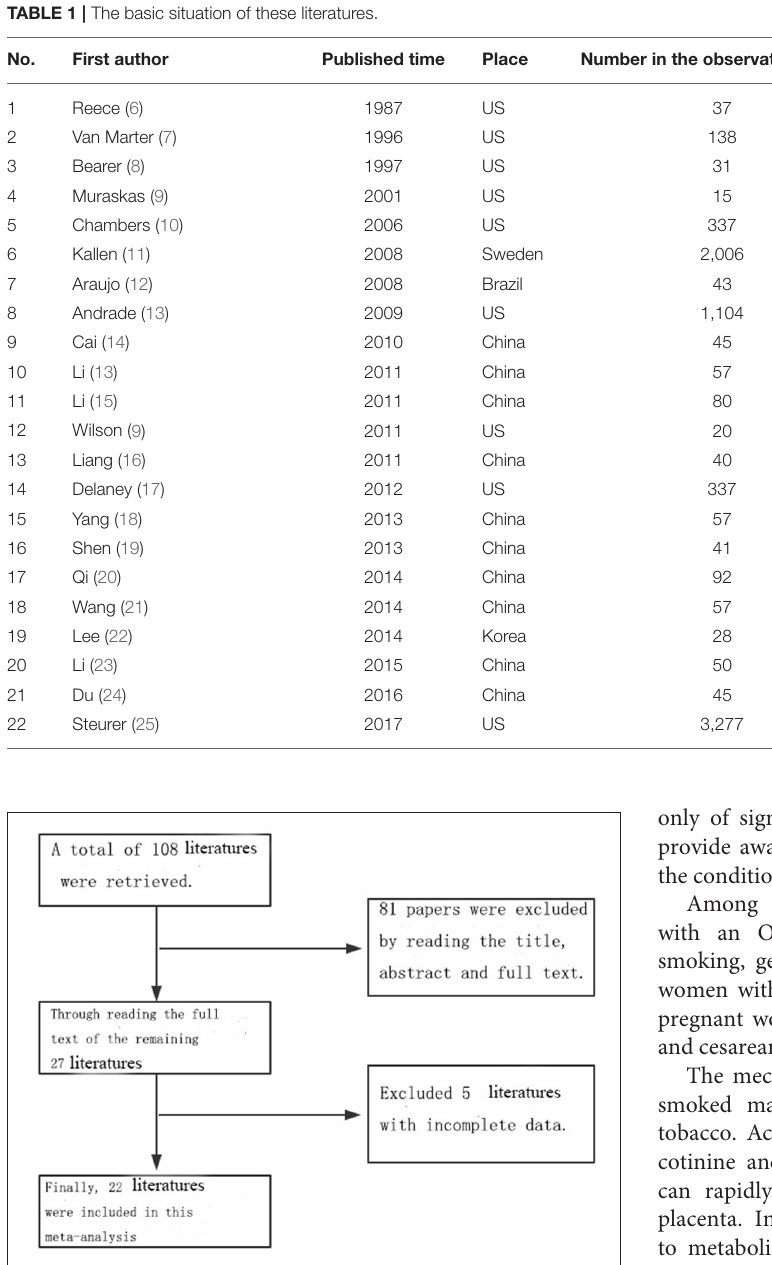
FIGURE 1 | The literature screening flow